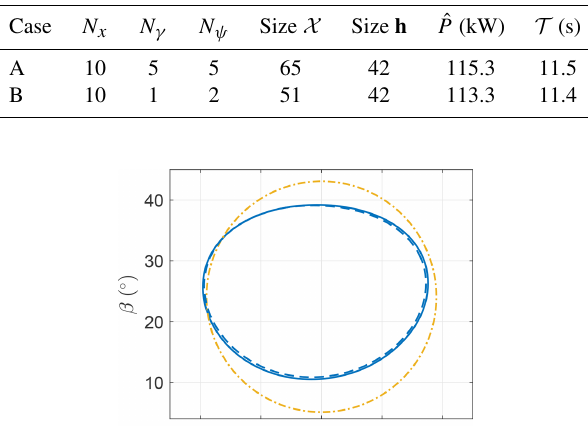
Table 5. Settings of the two optimal control problems maximizing the mean power considering gravity and wind shear.